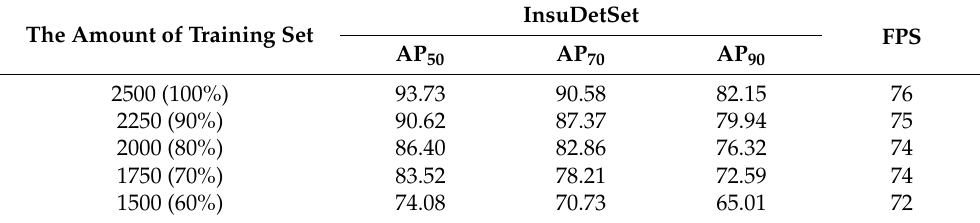
Table 9. Results of minimum training data experiment.